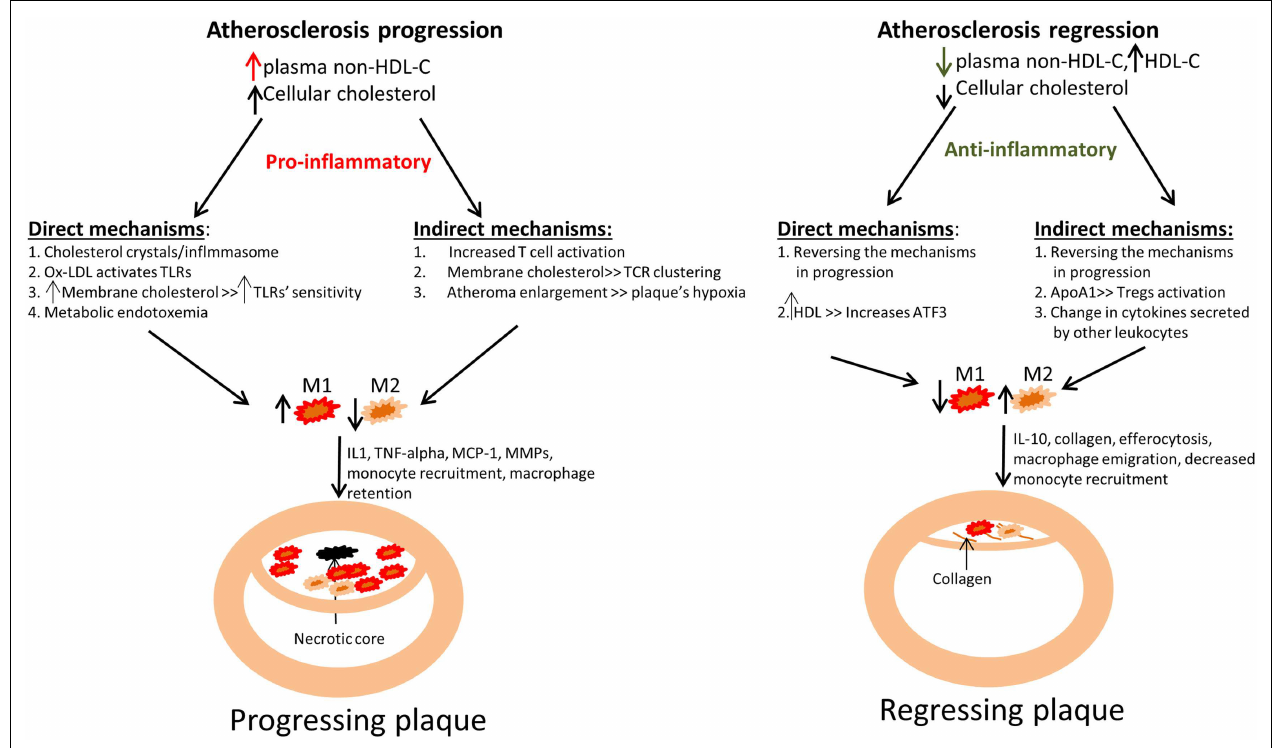
macrophage content (from decreased monocyte recruitment and macrophage retention), as well as enrichment in the expression of markers of the M2 state. Improved efferocytosis is also expected under these conditions, with shrinkage of the necrotic core.There is an increase in collagen content, likely from decreased MMP production by the macrophages. It is also likely that in a regression environment there are decreases in the secretion of inflammatory cytokines and chemokines by the macrophages as a result of the polarization of macrophages toward a M2-like state.The different mechanisms by which cholesterol can drive macrophage activation and polarization are divided into those direct – how cholesterol affects macrophages, and indirect – how cholesterol affects other cell types, for example by the secretion of